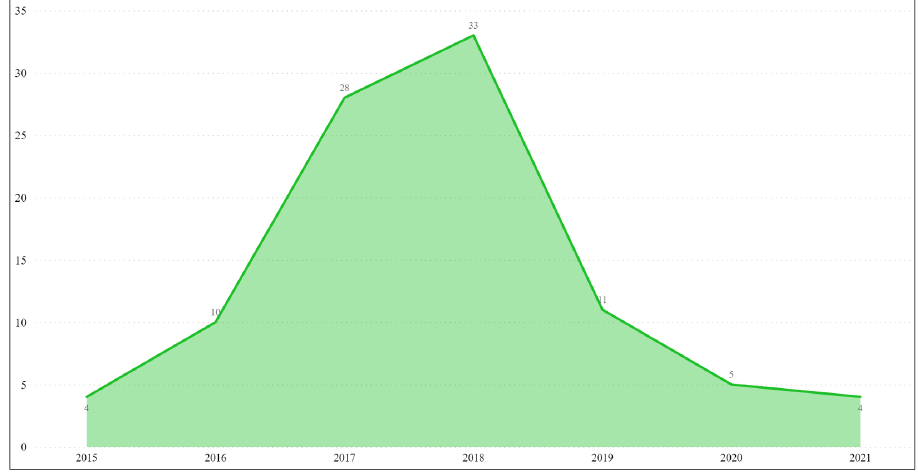
Figure 3. Publications separated by